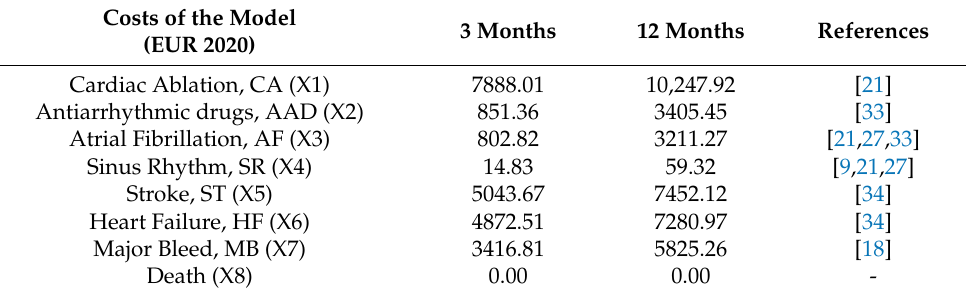
Table 2. Costs of the states of the